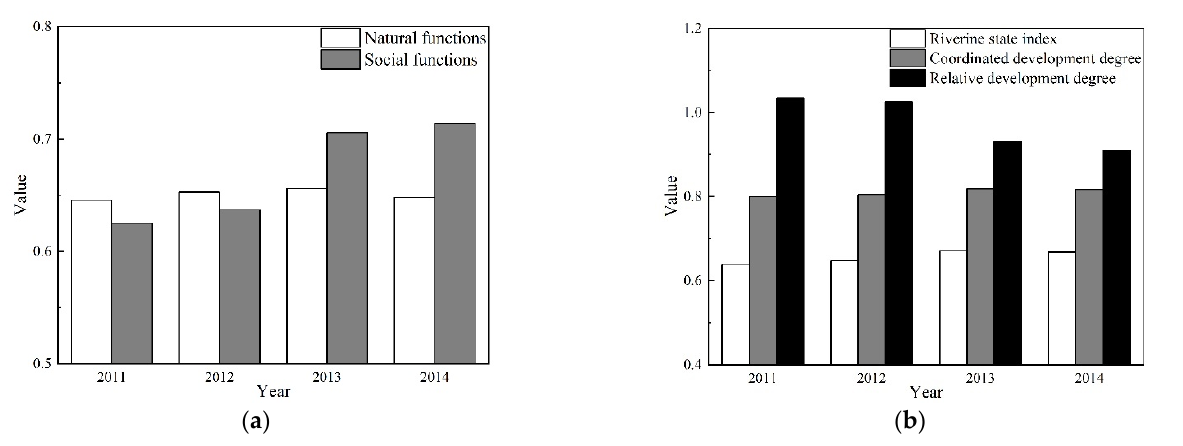
Figure 5. The overall results of the coordinated development degree assessment for the Lhasa River from 2011 to 2014. The specific indicators include: ( a ) Natural and social functions; ( b ) the riverine state index, coordinated and relative development